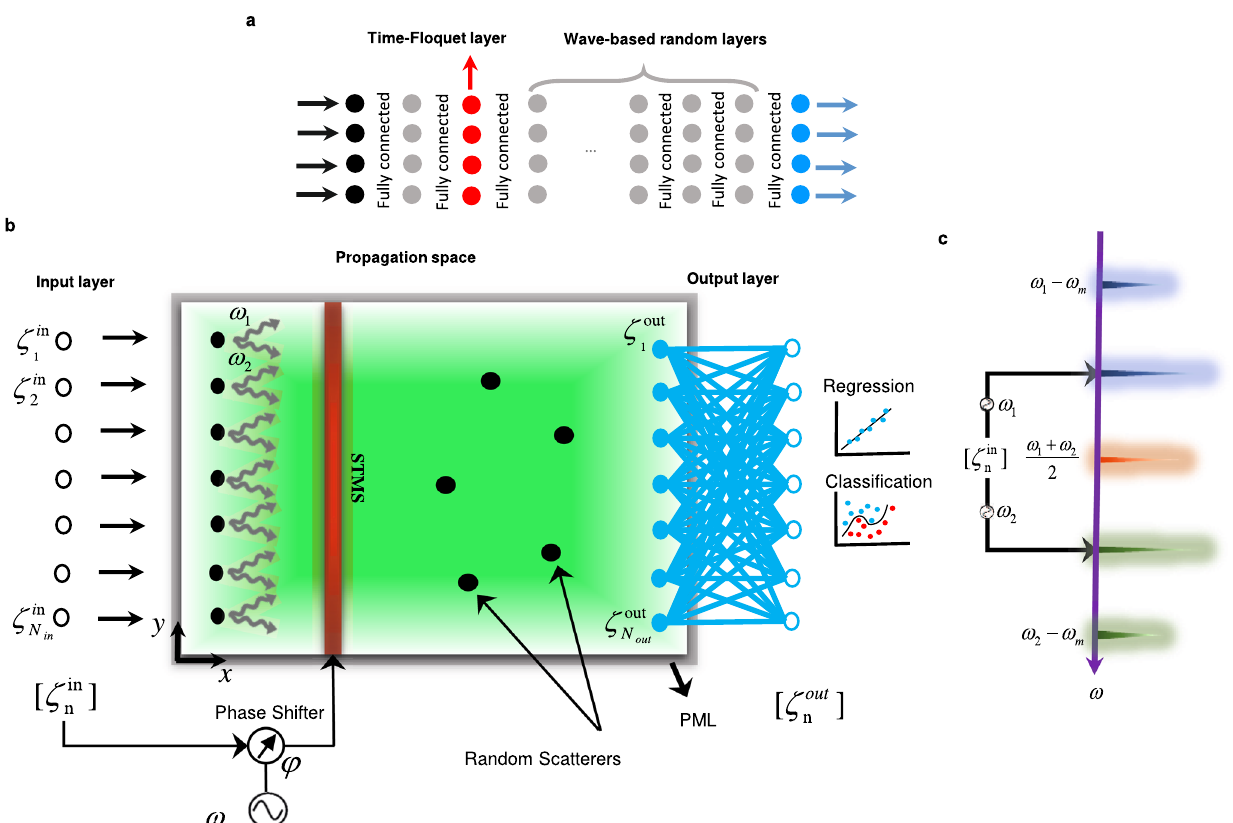
Fig. 1 Wave-based time-Floquet extreme learning machine. a Schematic of a neural network including a time-Floquet layer made from neurons whose properties are modulated periodically in time, and traditional random layers. Only the last layer (output) is trainable. b Concrete implementation with electromagnetic waves. The input signals ζ in n are modulated at ω 1 and ω 2 . The sums of these frequency components forms input signals that are independently radiated into the surrounding space by an array of source antennas (black disks). As the waves propagates in the green region, they encounter a thin dielectric slab whose index of refraction is modulated at the frequency ω m = ∣ ω 1 − ω 2 ∣ /2, as well as fi ve sub-wavelength scatterers, randomly located in the domain. The modulation phase depends on the input vector ζ in n ð t Þ . The gray rectangle represents an absorbing boundary layer. The outputs ζ out n ð t Þ are fed into an adaptable blue dense layer, and used for regression and classi fi cation. c Nonlinear phase entanglement. The modulated slab mixes signals at ω 1 and ω 2 into Floquet harmonics spaced by ω m , whose interferences depend non-linearly on the input